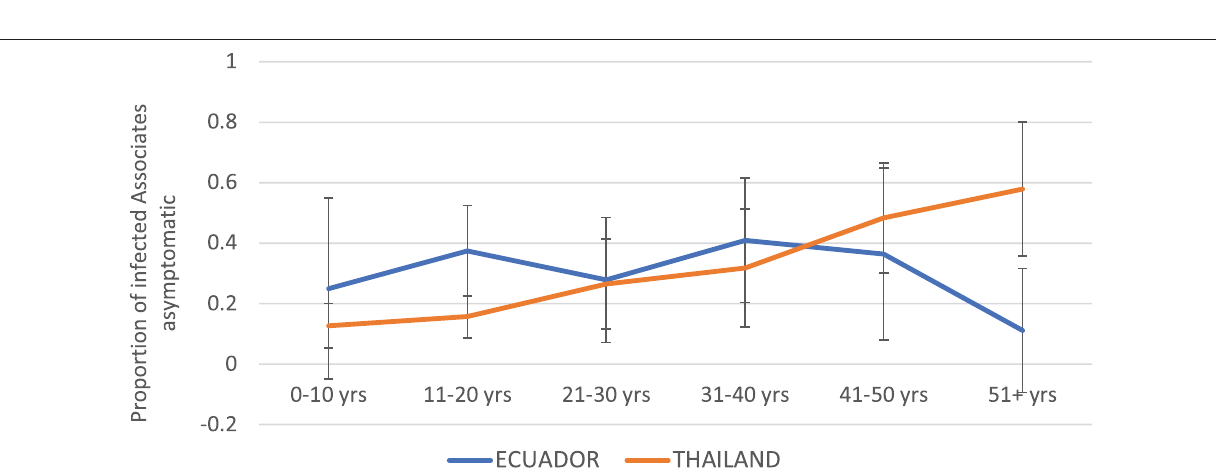
Frontiers in Public Health | www.frontiersin.org